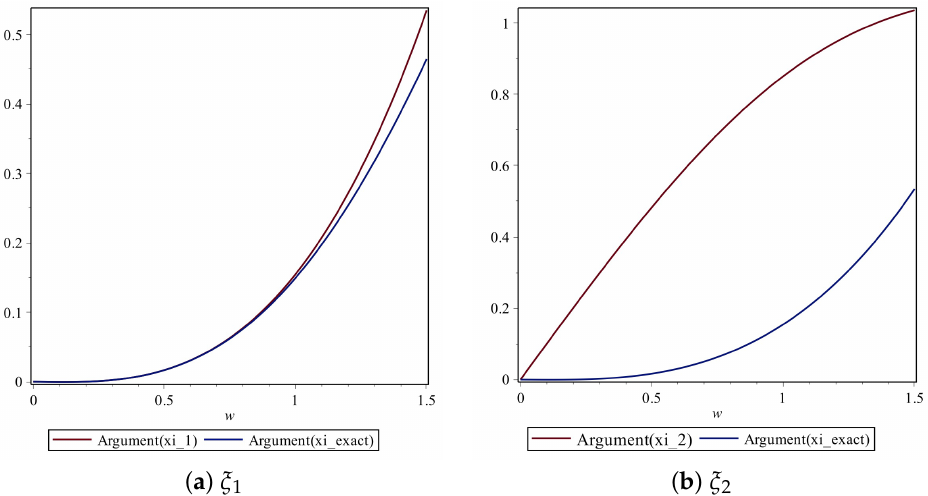
Figure 25. Plot of the arguments of amplification factors of Scheme 2 for Numerical Experiment 2 with the spatial and temporal step sizes h = π /10 and k = 0.001,